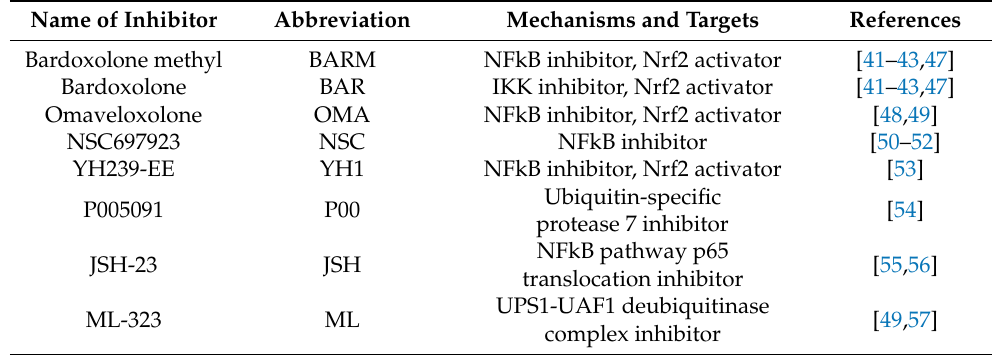
Table 1. Inhibitors of UPS-mediated signaling